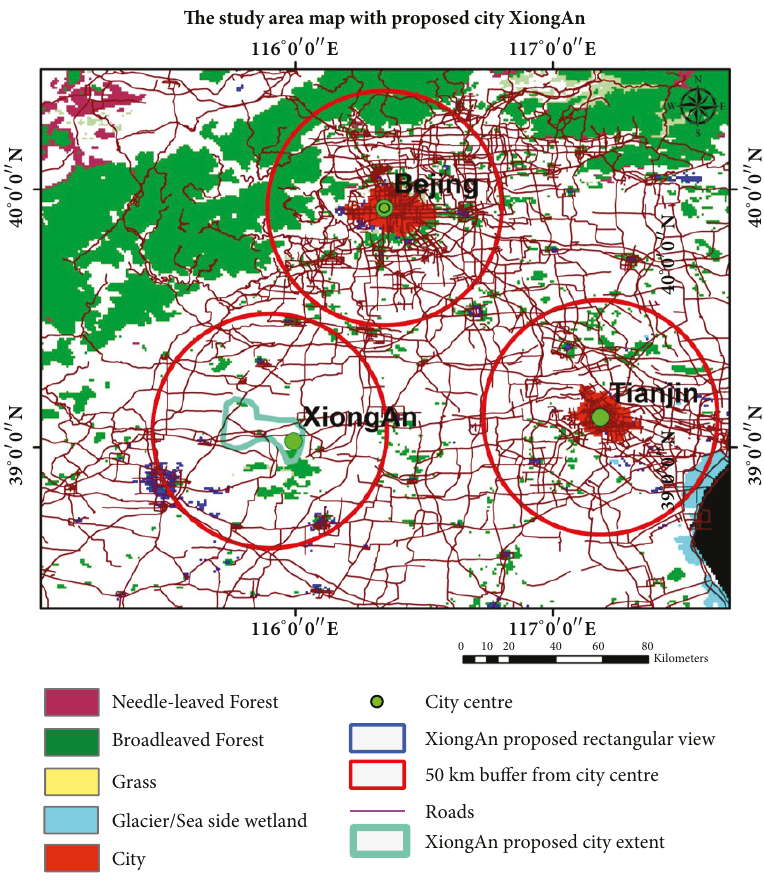
Figure 1: Beijing, Tianjin, and Hebei road network